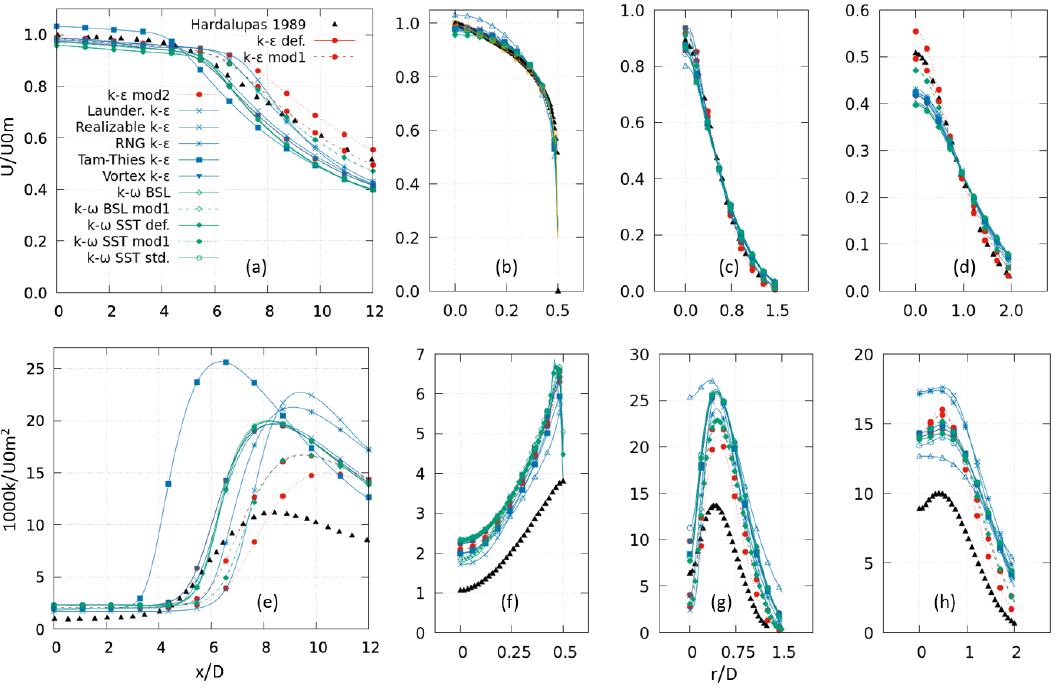
Figure 4. Test case Bogusławski and Popiel [27] normalized velocity profiles at ( a ) axial and ( b ) 0D, ( c ) 6D, and ( d ) 12D normal planes, and normalized turbulent kinetic energies at ( e ) axial, and ( f ) 0D, ( g ) 6D, and ( h ) 12D normal